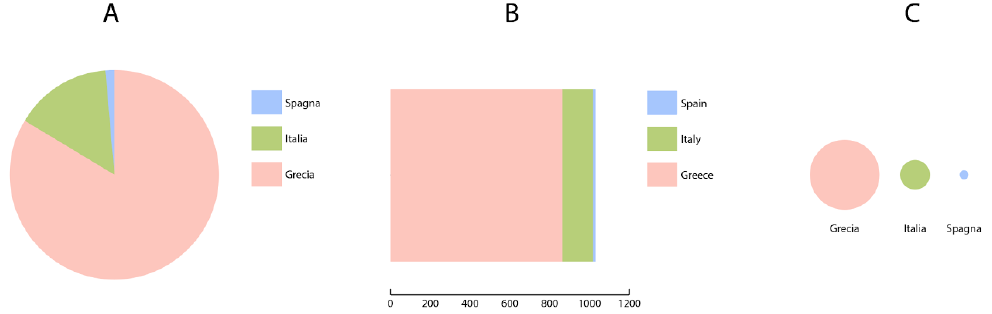
Figure 3. Three hypothetical forms of data visualization about migrant landings in Europe (2015— source: